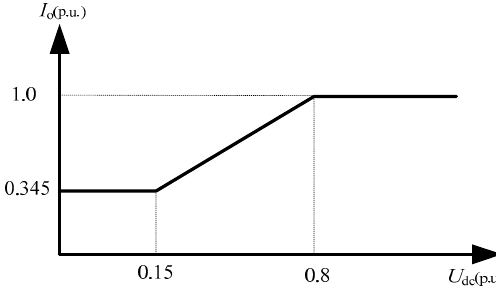
Figure 15. The static characteristic of the voltage dependent current order limiter (VDCOL).